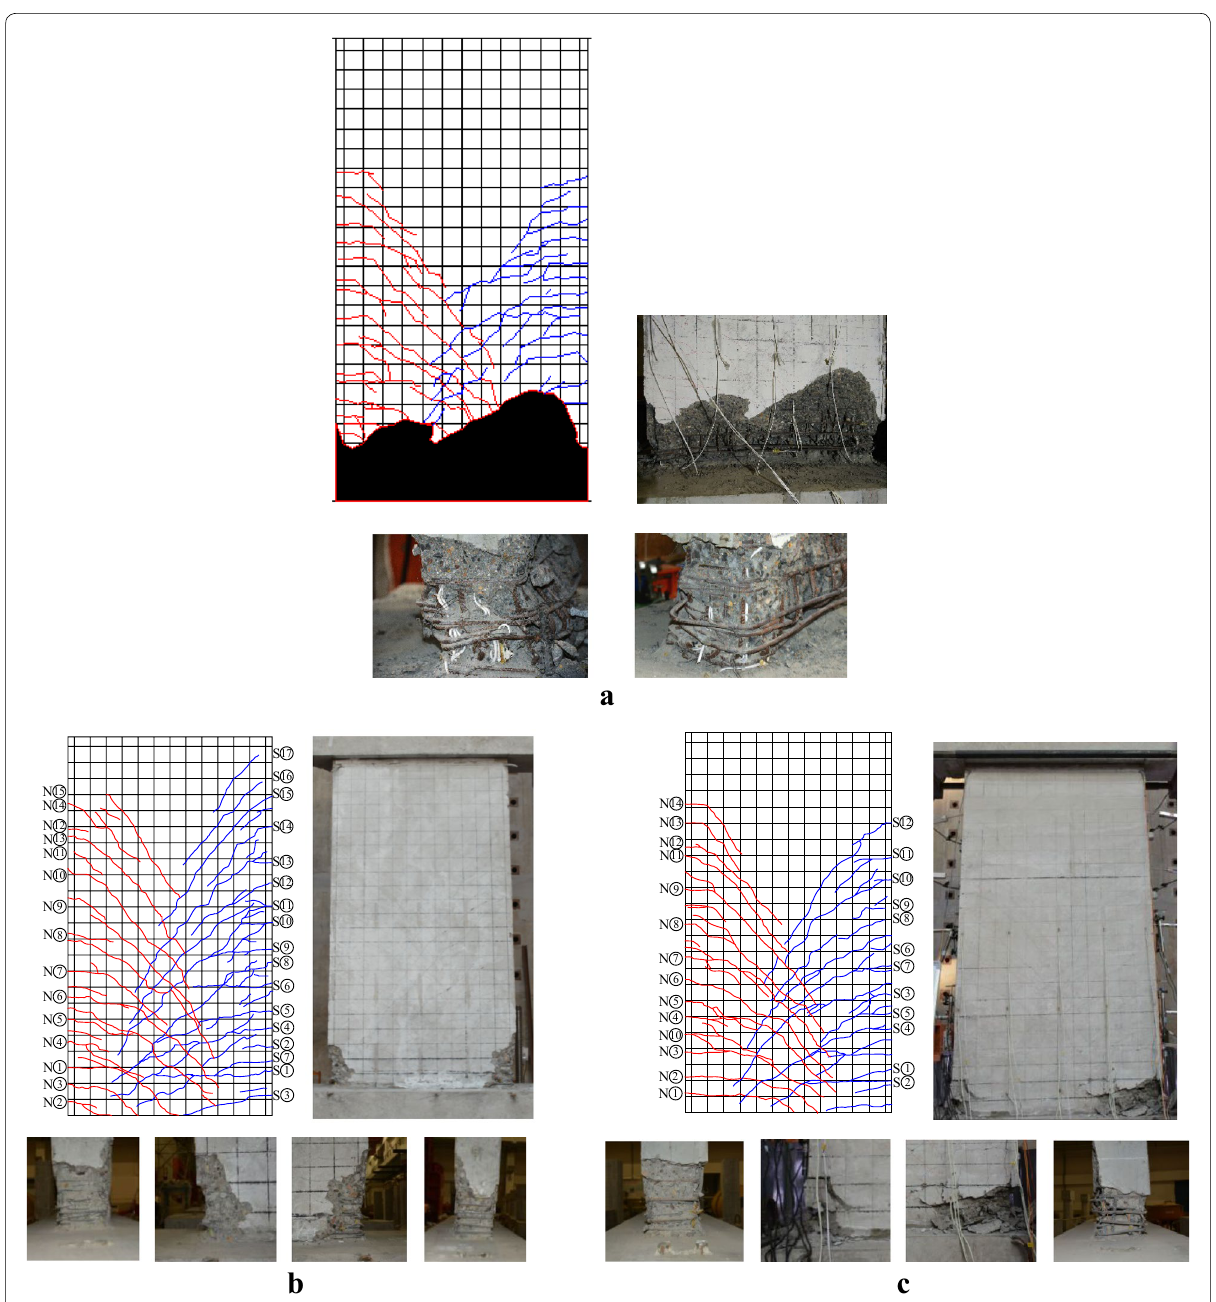
Fig. 7 Cracks and failure modes ( a RCSW, b CFRPRW1, c CFRPHW1, d CFRPRW2, e CFRPHW2, f CFRPRW3, g